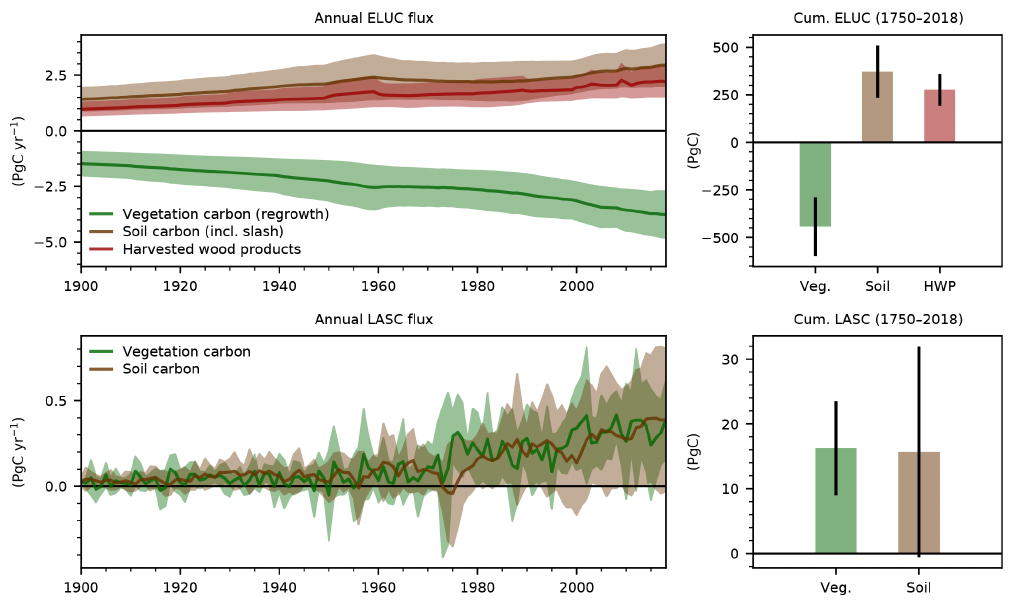
Figure 6. Breakdown of our best-guess estimates by carbon pools: vegetation (green), soils (brown), and HWPs (red). Shaded areas and uncertainty bars represent the 1 σ uncertainty